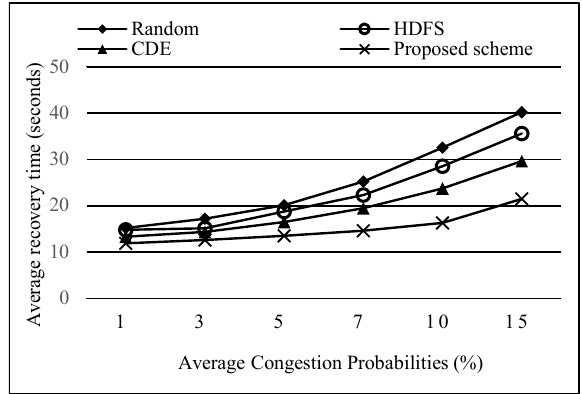
Fig. 11. Average recovery time with different congestion probabilities.